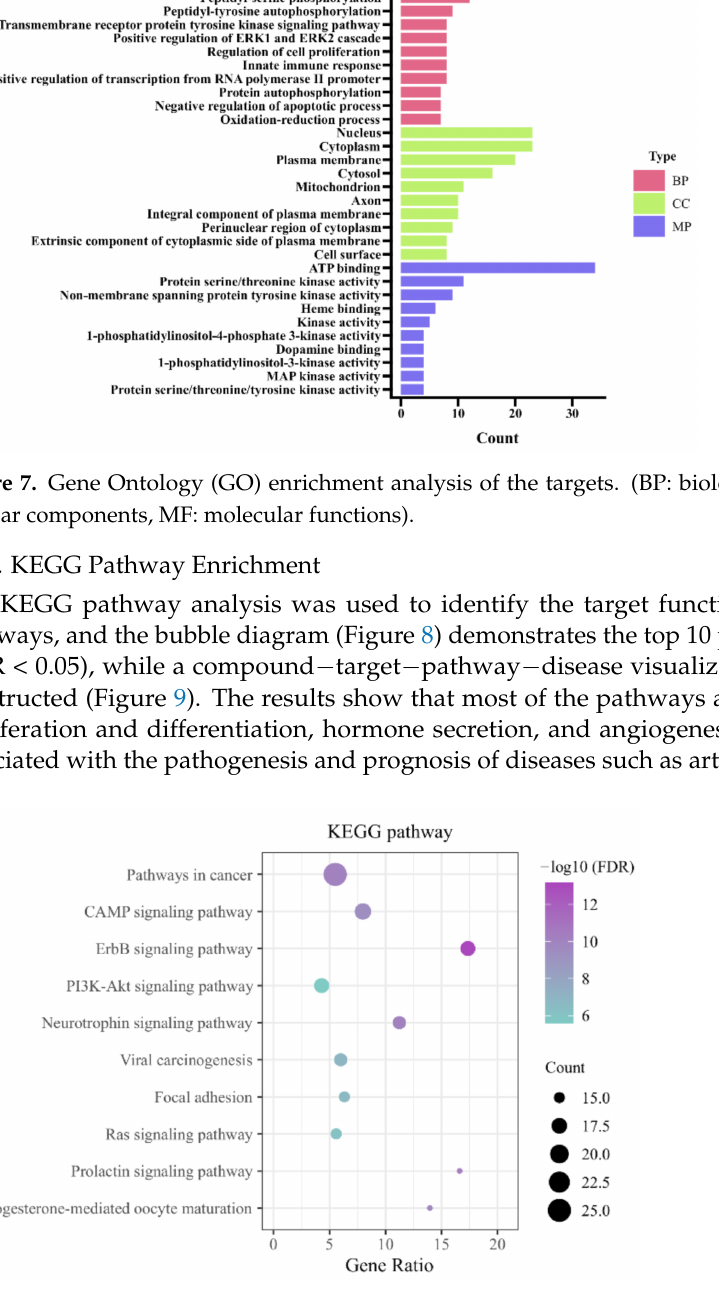
Figure 8. KEGG pathway enrichment analysis of the